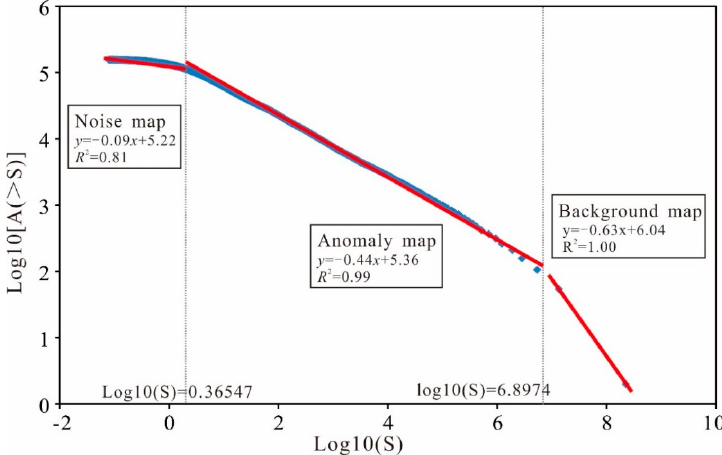
Figure 9. Log–log plot of spectrum density (S) versus the area with greater than or equal to S.